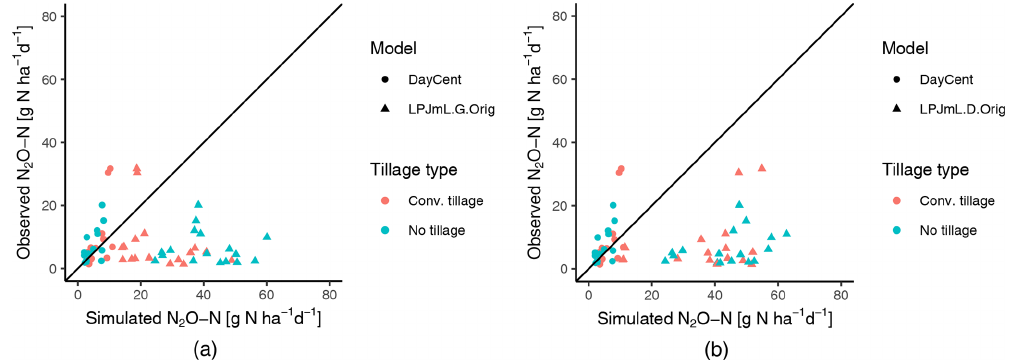
Figure 1. Comparison of observed and simulated yearly averages of N 2 O emissions by tillage type and models LPJmL.G.Orig (a) , LPJmL.D.Orig (b) and DayCent. The data refer to all four sites and years of the experiments. Each point represents the average of all measured daily values within 1 year and tillage treatment. Tillage types are indicated by different